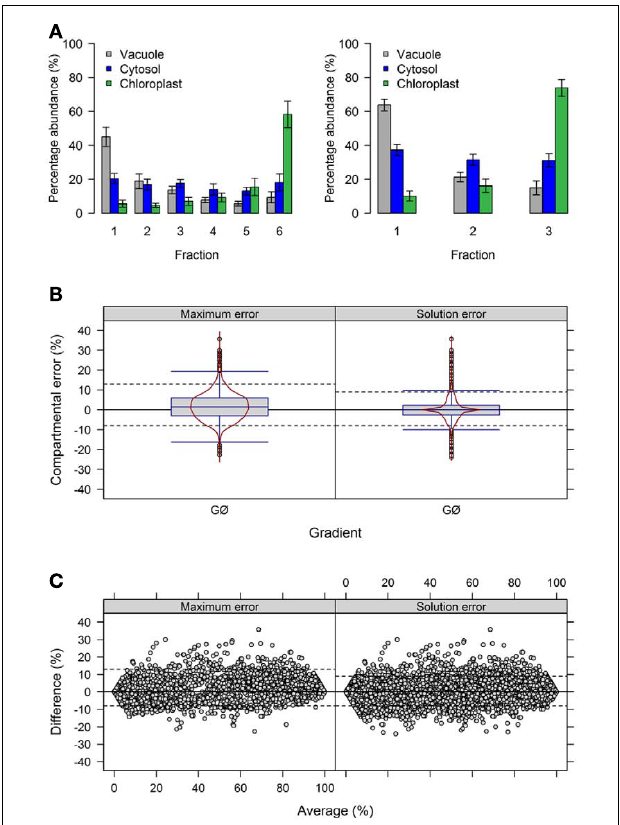
FIGUREA5 | Influence of the number of collected fraction on estimated compartmental abundances based on experimental data. (A) Bar plots depicting the mean–averages and SDs of the three compartment-specific markers for each of the three resolved compartments on the basis of 6 and 3 collected fractions. Neighboring fractions, i.e., 1 + 2, 3 + 4, and 5 + 6, were averaged to obtain results for 3 fractions. (B) Combined box- and violin plots (red lines) as well as (C) mean-difference plots showing the difference of the maximum and solution error based on compartmental abundances estimated using BFA for gradients comprising 6 and 3 fractions. For both, positive values indicate larger compartmental abundances for 6 fractions while negative values depict larger abundances for 3 fractions.The 5th and 95th percentiles are drawn as black dashed lines.The figures show the average of three independent